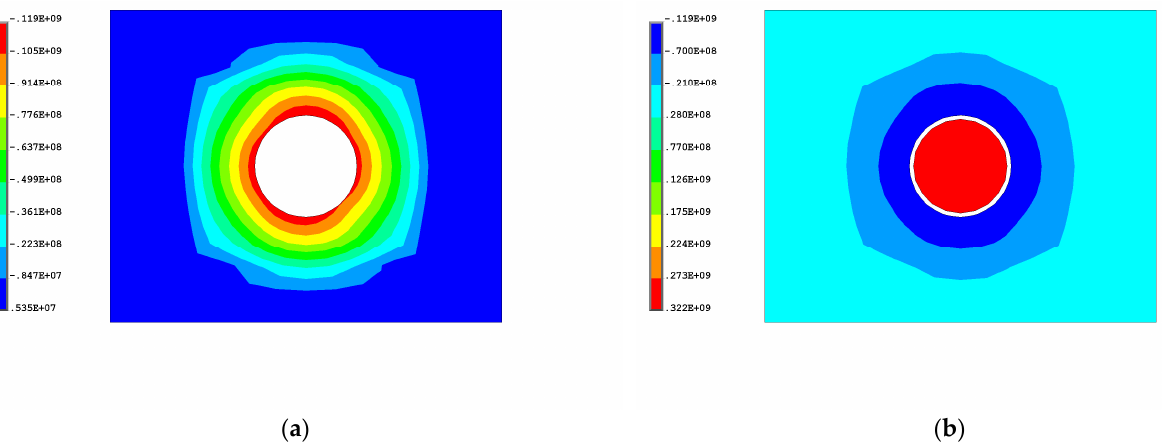
Figure 8. Normal pressure distribution: ( a ) On the contact surface between beams; ( b ) Section view on the contact surface between beams.